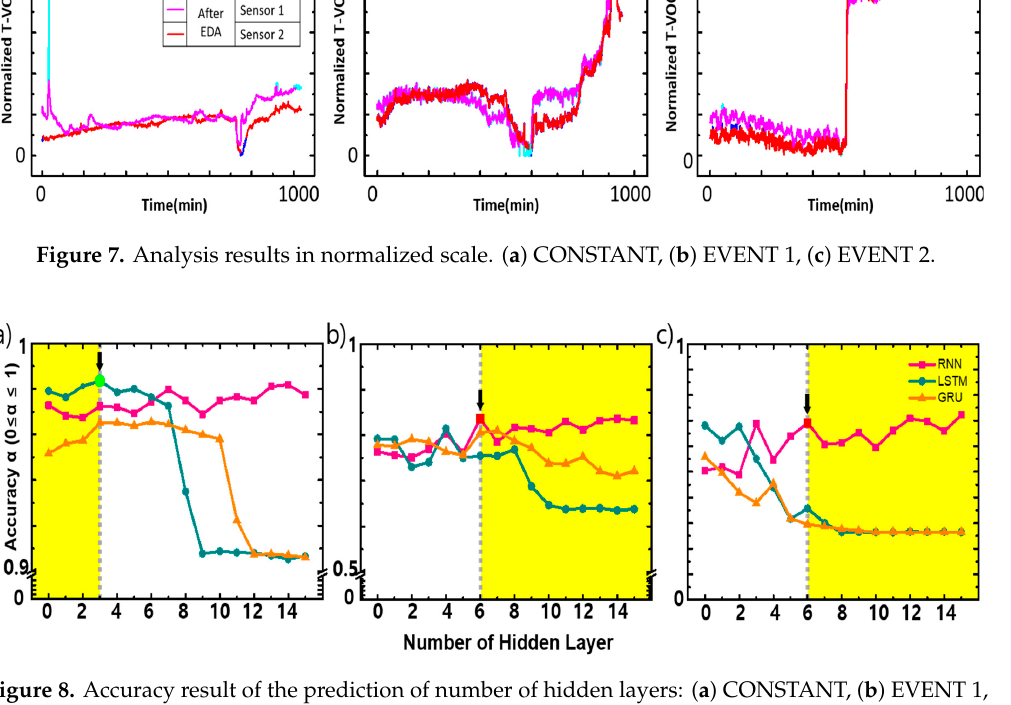
Figure 7. Analysis results in normalized scale. ( a ) CONSTANT, ( b ) EVENT 1, ( c ) EVENT 2.